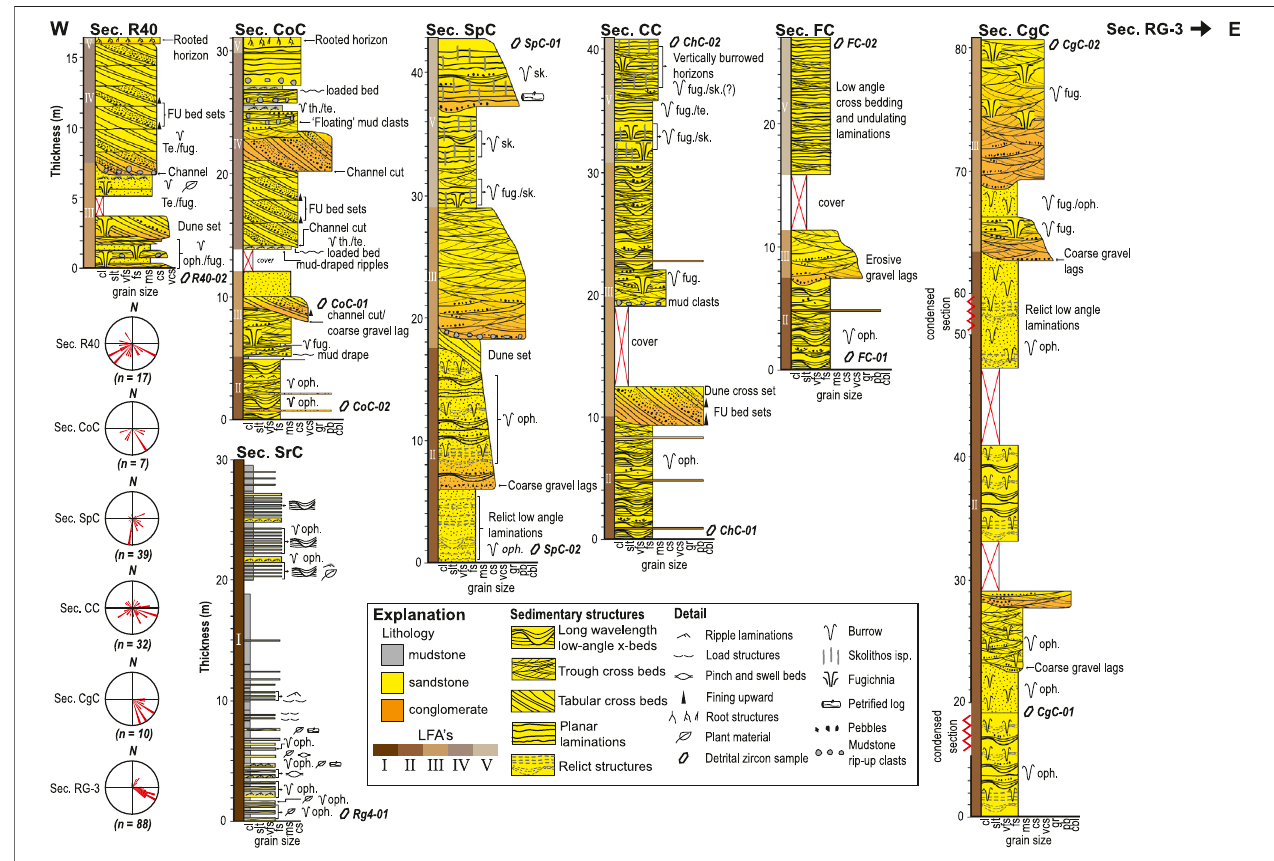
FIGURE 4 | Measured stratigraphic sections and paleocurrent results from the La Anita Formation from the Zona Centro region ( Figure 3A ). Sections are at the meter scale with grain size is on the x -axis (cl, clay; slt, silt; vfs, very fi ne sand; fs, fi ne sand; ms, medium sand; cs, coarse sand; vcs, very coarse sand; gr, granule; pb, pebble; cbl, cobble). Colored sections labeled with roman numerals are lithofacies associations. Homogeneous sections are condensed and signi fi ed by a red, vertical zig-zagline.AdetailedstratigraphicsectionofsectionRG-3isavailablein SupplementaryFigureS1 . Fug ,fugichniaescapeburrows; Oph , Ophiomorphaisp .; Sk , Skolithos isp. ; Th/Te , Thalassinoides/ Teredolites isp.